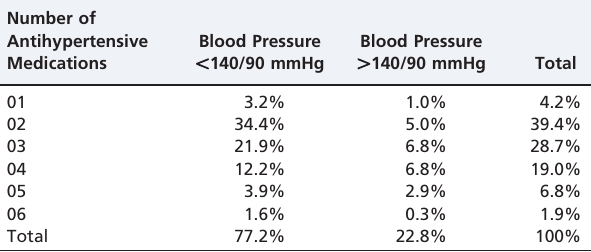
Table 4 - Number of antihypertensive medications in use at the end of the study in patients who achieved control ( , 140/90 mmHg) of their blood pressure at the end of the 12-month study.